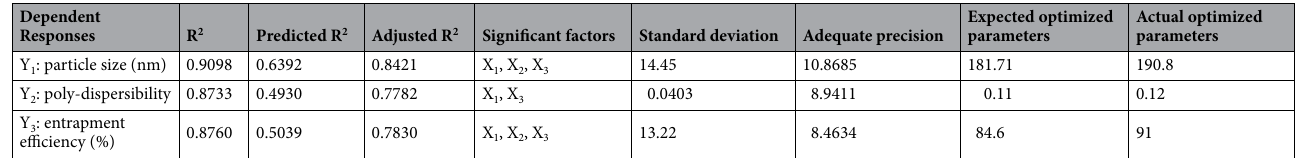
Table 3. Summary of applied 2 3 factorial design, significant factors and optimized values of response factors.